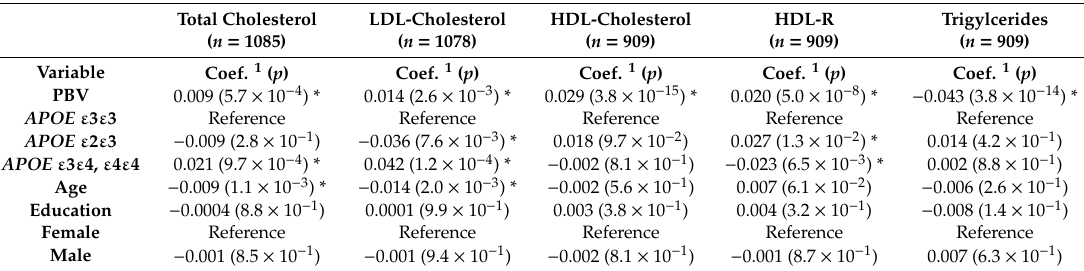
Table 4. Multivariate association of clinical and biological variables with serum lipids.